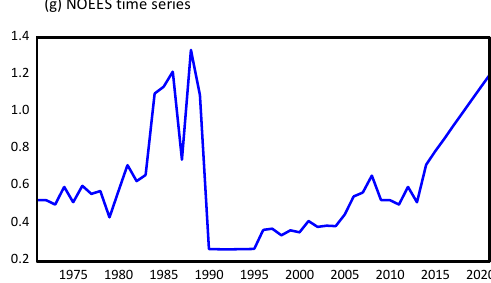
Figure 1. Time series plot for di ff erent variables.